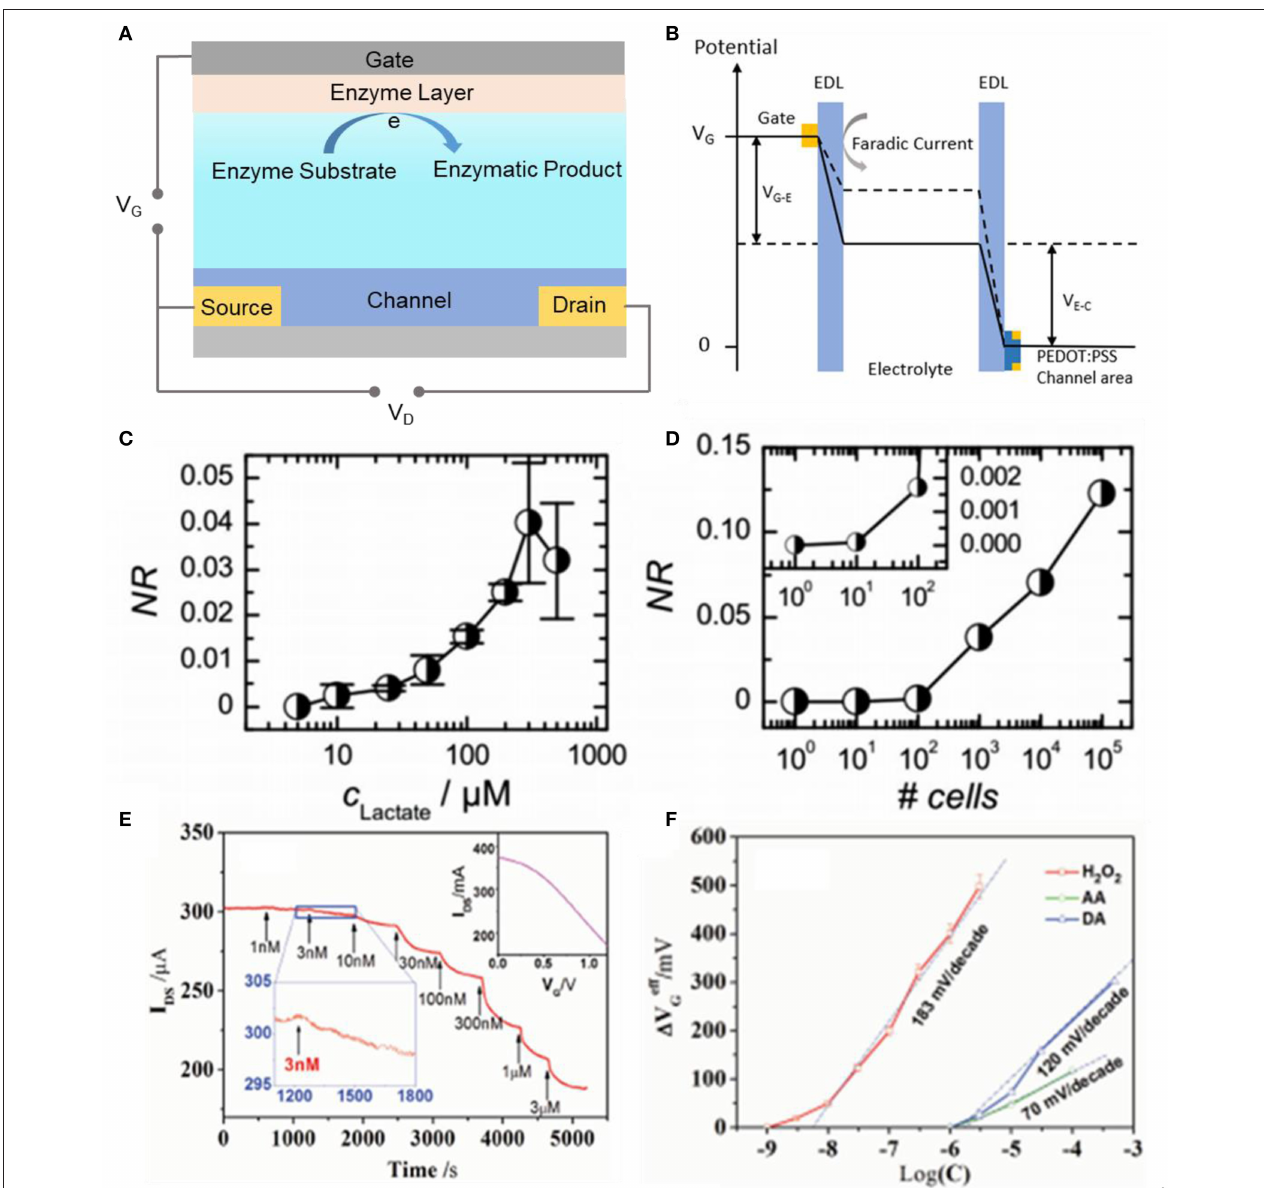
FIGURE 6 | Schematic working principle of an enzyme modified OECT sensor of (A) the reaction on the enzymatic gate electrode and (B) typical potential drop between the channel and gate with the addition of substrate. Characteristics of the sensitivity (C) of lactate sensor of three devices [NR (normalized response) = 1 V out / 1 V out,max ] and (D) titration curve of one selected device with consecutive addition of substrate collected from cells culture of different concentrations (Braendlein et al., 2017b). Reproduced with permission (Braendlein et al., 2017b). Copyright © 2017 WILEY-VCH Verlag GmbH & Co. KGaA, Weinheim. (E) Titration curve of an OECT modified with PANI/Nafion-graphene/Pt as gate electrode to the additions of H 2 O 2 . Inset: transfer curve of the device (Liao et al., 2015). (F) The effective gate voltage ( 1 V G eff ) vs. different concentrations of H 2 O 2 , AA, and DA (Liao et al., 2015). Reproduced with permission (Liao et al., 2015). Copyright © 2014 WILEY-VCH Verlag GmbH & Co. KGaA, Weinheim.